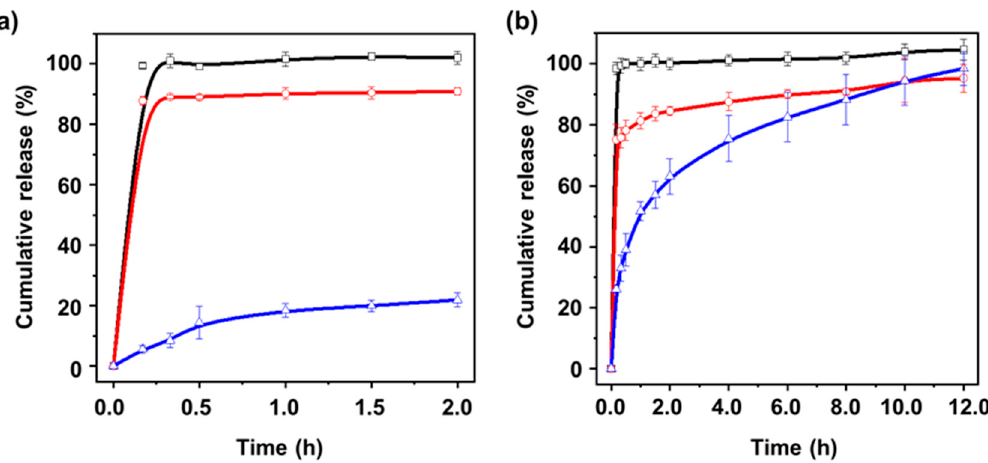
Figure 3. In vitro release profiles of NA from intact NA ( ─ □ ─ ), NA-LDH ( ─ ○ ─ ), Eudragit ® S100- coated NA-LDH ( ─ △ ─ ) ( a ) pH 1.2 medium and ( b ) pH 6.8 one.